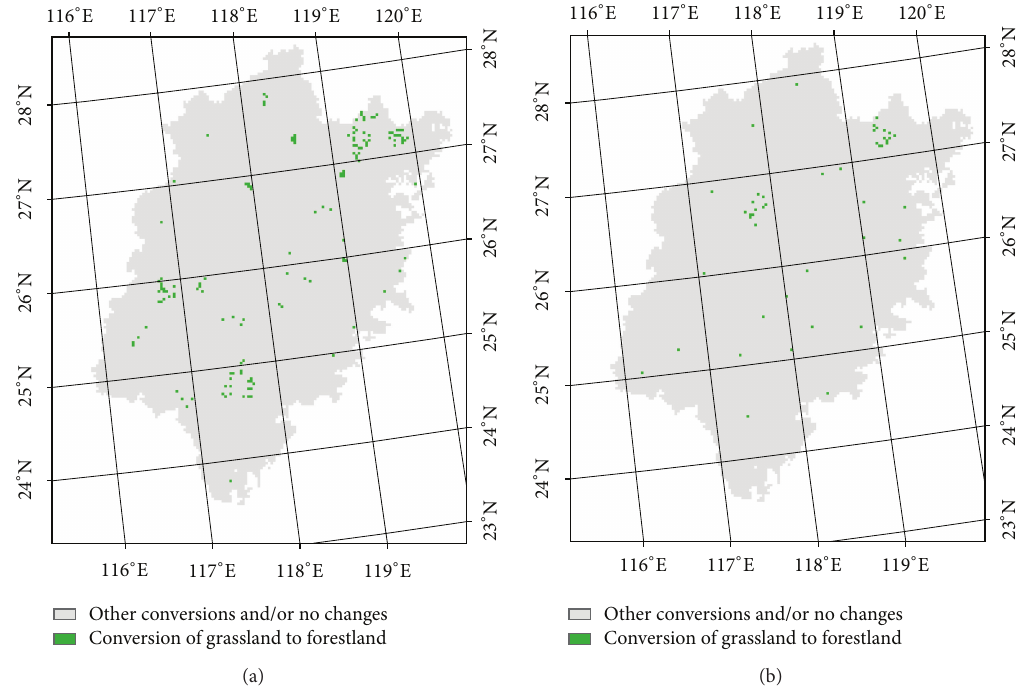
Figure 5: Spatial pattern of the conversion (measured in 3 km) from grassland to forestland in 2010–2050 under RCP6 (a) and RCP8.5 (b) in Fujian